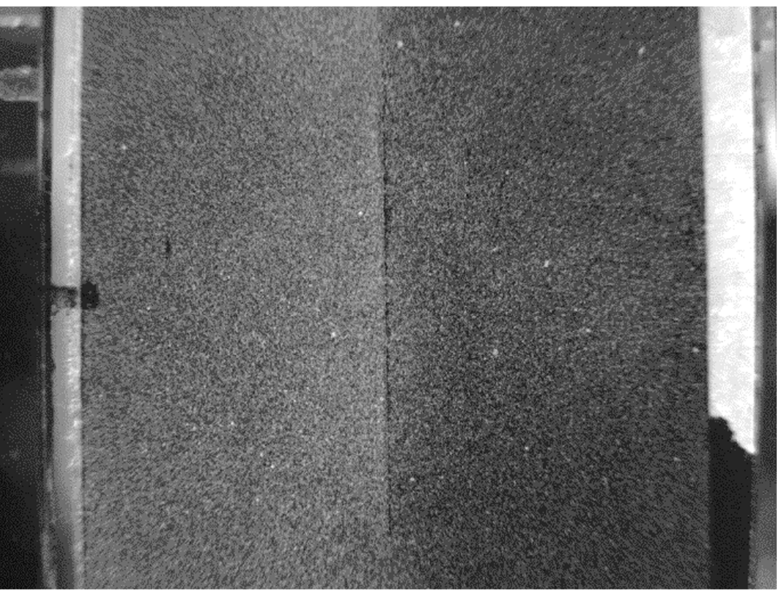
Figure 6. Image for the selection of subset sizes, image distortion correction, and rigid body translation.